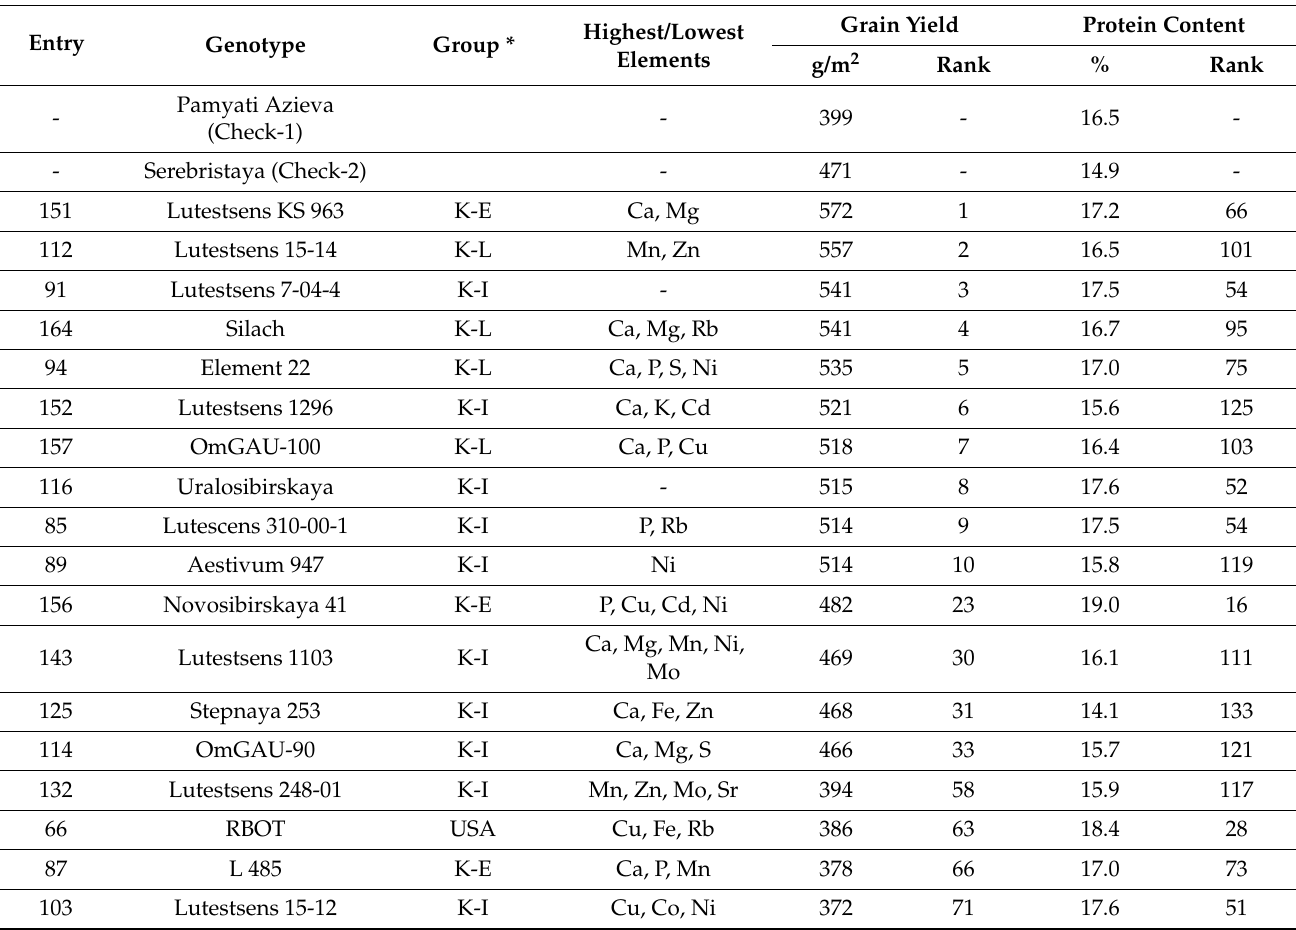
Table 4. Genotypes with the highest grain yield, highest concentrations of macro- and microelements, and lowest concentrations of trace